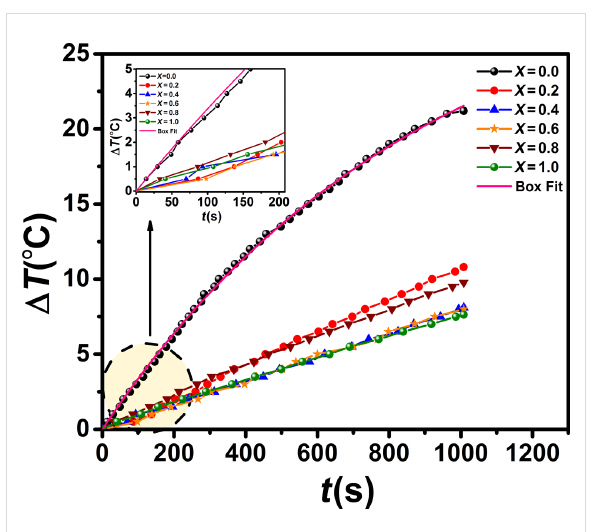
Figure 13: Temperature rise in Co x Fe 3 − x O 4 suspensions in an ac magnetic field (27 Oe, 92 kHz) as a function of the time. The inset shows the temperature rise in the first 200 s. The pink straight line for x = 0 is a fit resulting from the Box–Lucas